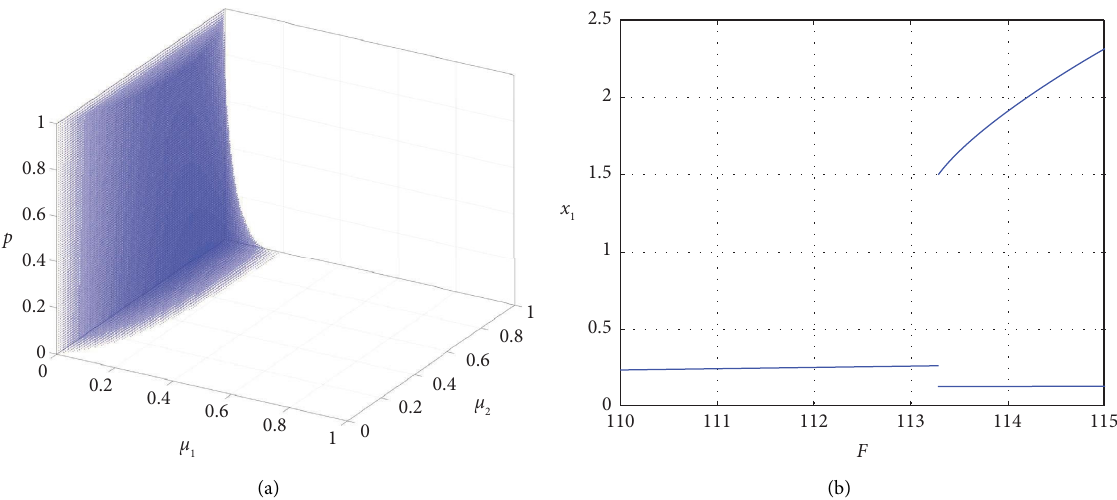
,x ∗ ) undergoes a subcritical bifurcation when 1 2